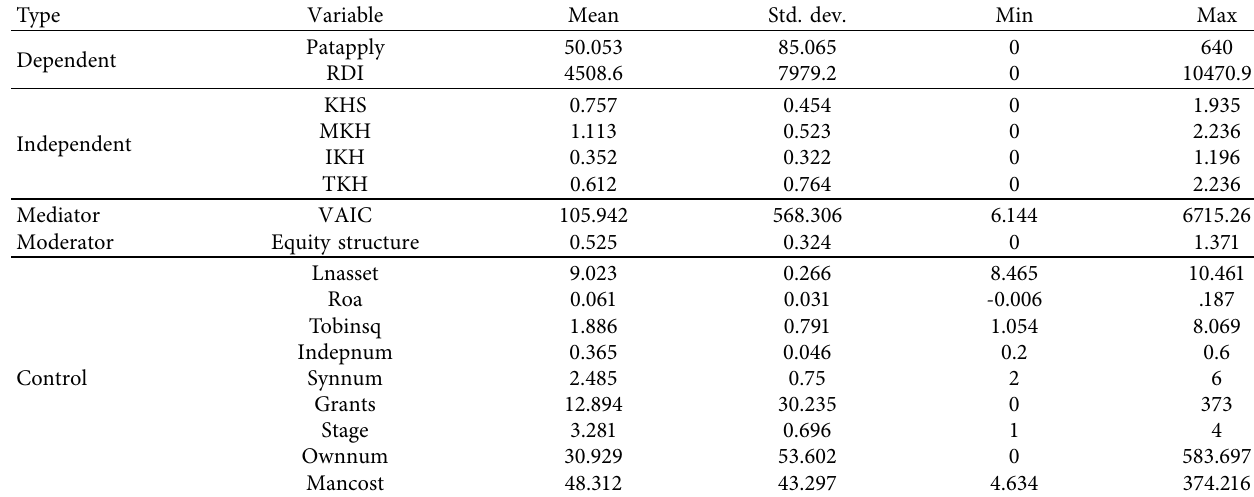
Table 3: Descriptive analysis of